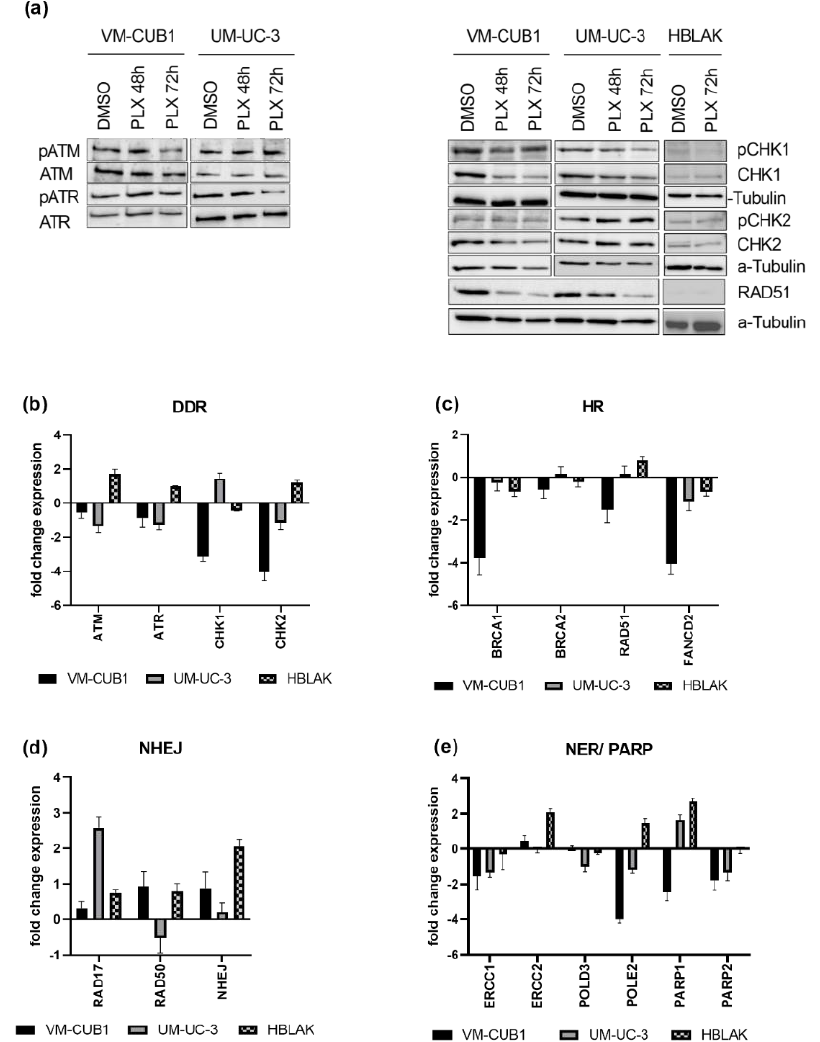
Figure 4. PLX impairs DNA damage signaling and induces DNA repair deficiency. ( a ) Activation of checkpoint proteins through phosphorylation was determined by western blot analysis after treatment for 48 h and 72 h with cell line-specific IC 50 doses of PLX. Respective total proteins and α -Tubulin were detected as loading controls. Likewise, RNA expression was determined in ( b ) by qRT-PCR 72 h after PLX treatment. RNA expression of key components of HR (homologous recombination) ( c ) was measured accordingly. RNA expression of NHEJ (non-homologous end joining) ( d ), NER (nucleotide excision repair), and PARP genes ( e ) was measured by qRT-PCR and normalized to the reference gene TBP . Expression changes are displayed as fold change relative to the respective DMSO